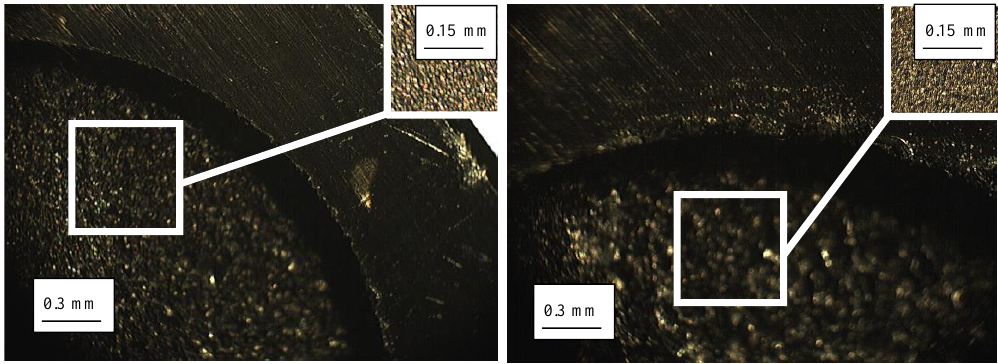
Figure 7. Details of the best ( left ) and worst ( right ) edge and surface finish with the MoCuSi ingot.